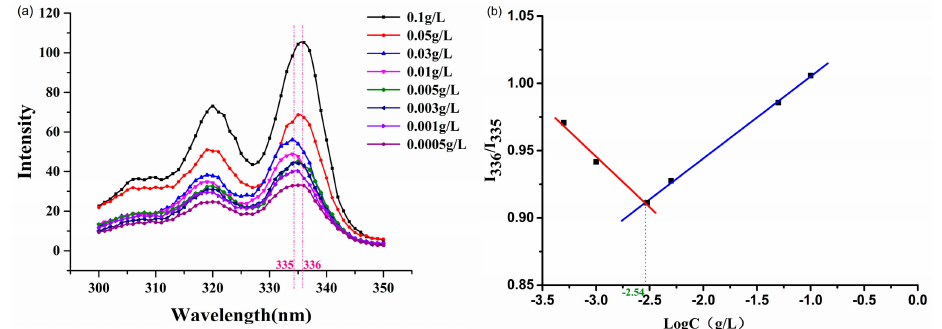
Figure 2. ( a ) Emission spectra of pyrene as a function of copolymer concentration and ( b ) fluorescence intensity ratio of I 336 / I 335 ratio from emission spectra vs. log concentration of the copolymers at pH